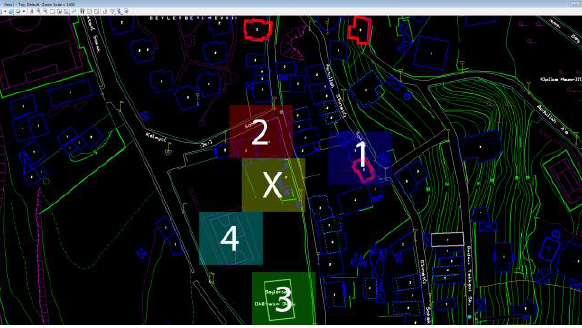
Figure 8. The location of the actual buildings